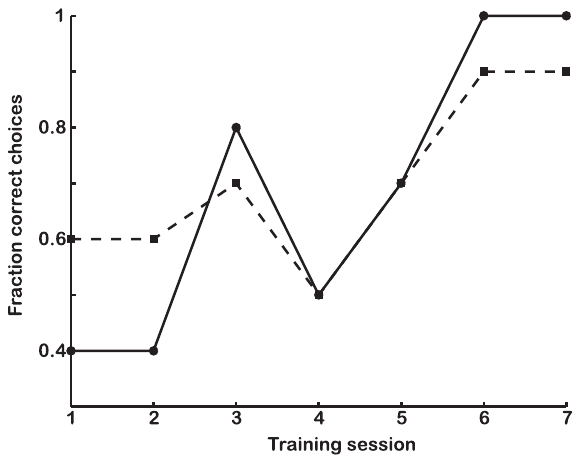
Figure 2. Brightness discrimination in budgerigars. Each data point represents the correct choice frequency for one bird and 40 choices. The three different markers (squares, filled circles and plus signs) indicate the results from each of the three individuals tested. A logistic function (Eq. 1) was fitted to the data (dashed line) from which the threshold was interpolated (filled diamond). Error bar shows the 68% confidence interval for the fitted function (obtained by using the program confint in Matlab). The brightness discrimination threshold at 72.5% correct choices (binomial test, n =40, p , 0.01) is 0.09 Michelson contrast